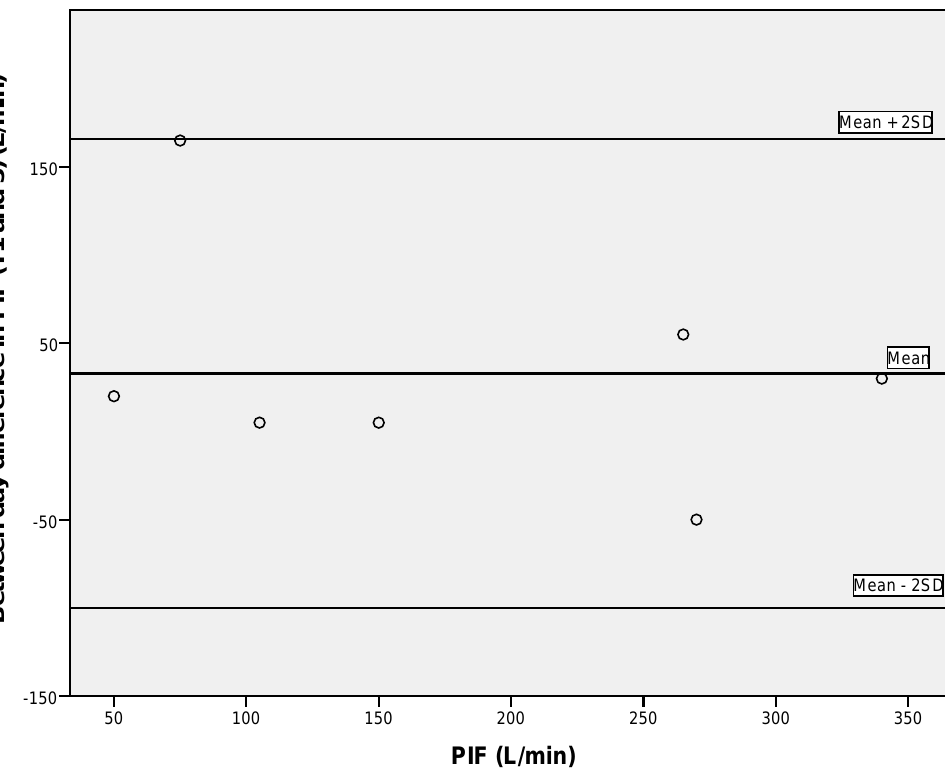
Figure 4. Bland–Altman plot showing between day variation for PIF between time point 1 and